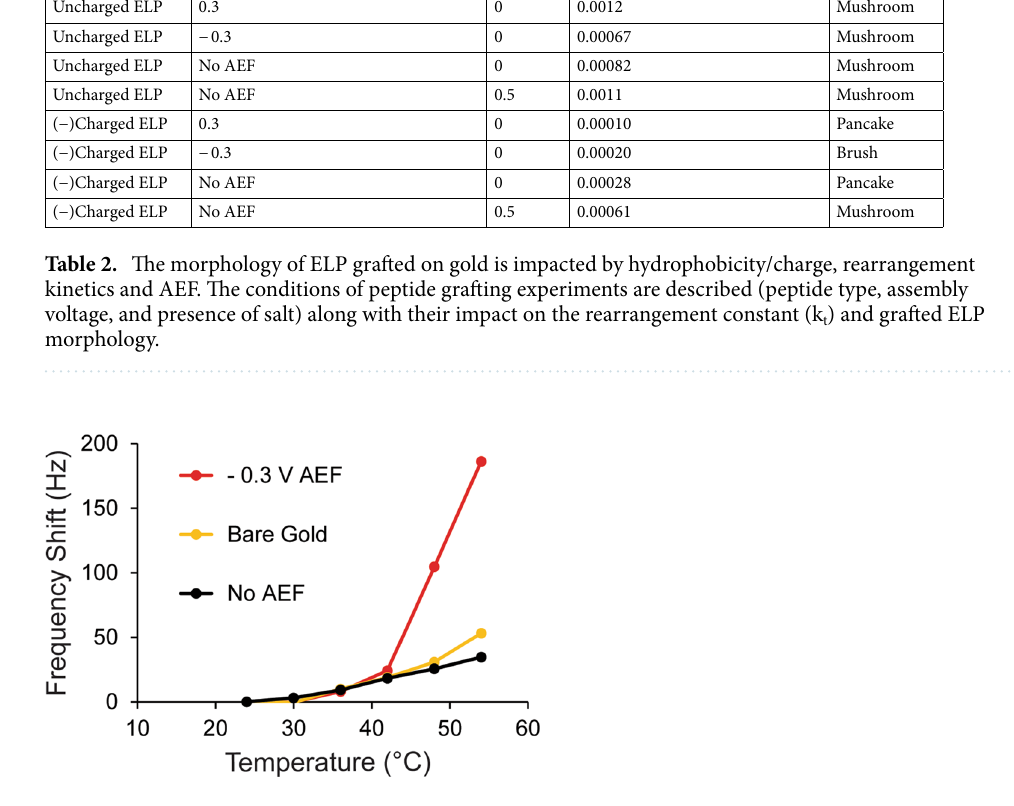
Figure 6. The surface-bound transition behavior of (−)charged ELP is impacted by assembly in an AEF. A bare gold control (yellow), (−)charged ELP assembled without an AEF (black) and (−)charged ELP assembled in − 0.3 V AEF vs. Ag/AgCl (red) were heated in 6 °C increments while the frequency shift was monitored. Lines between data points are added to help readers more clearly see the frequency